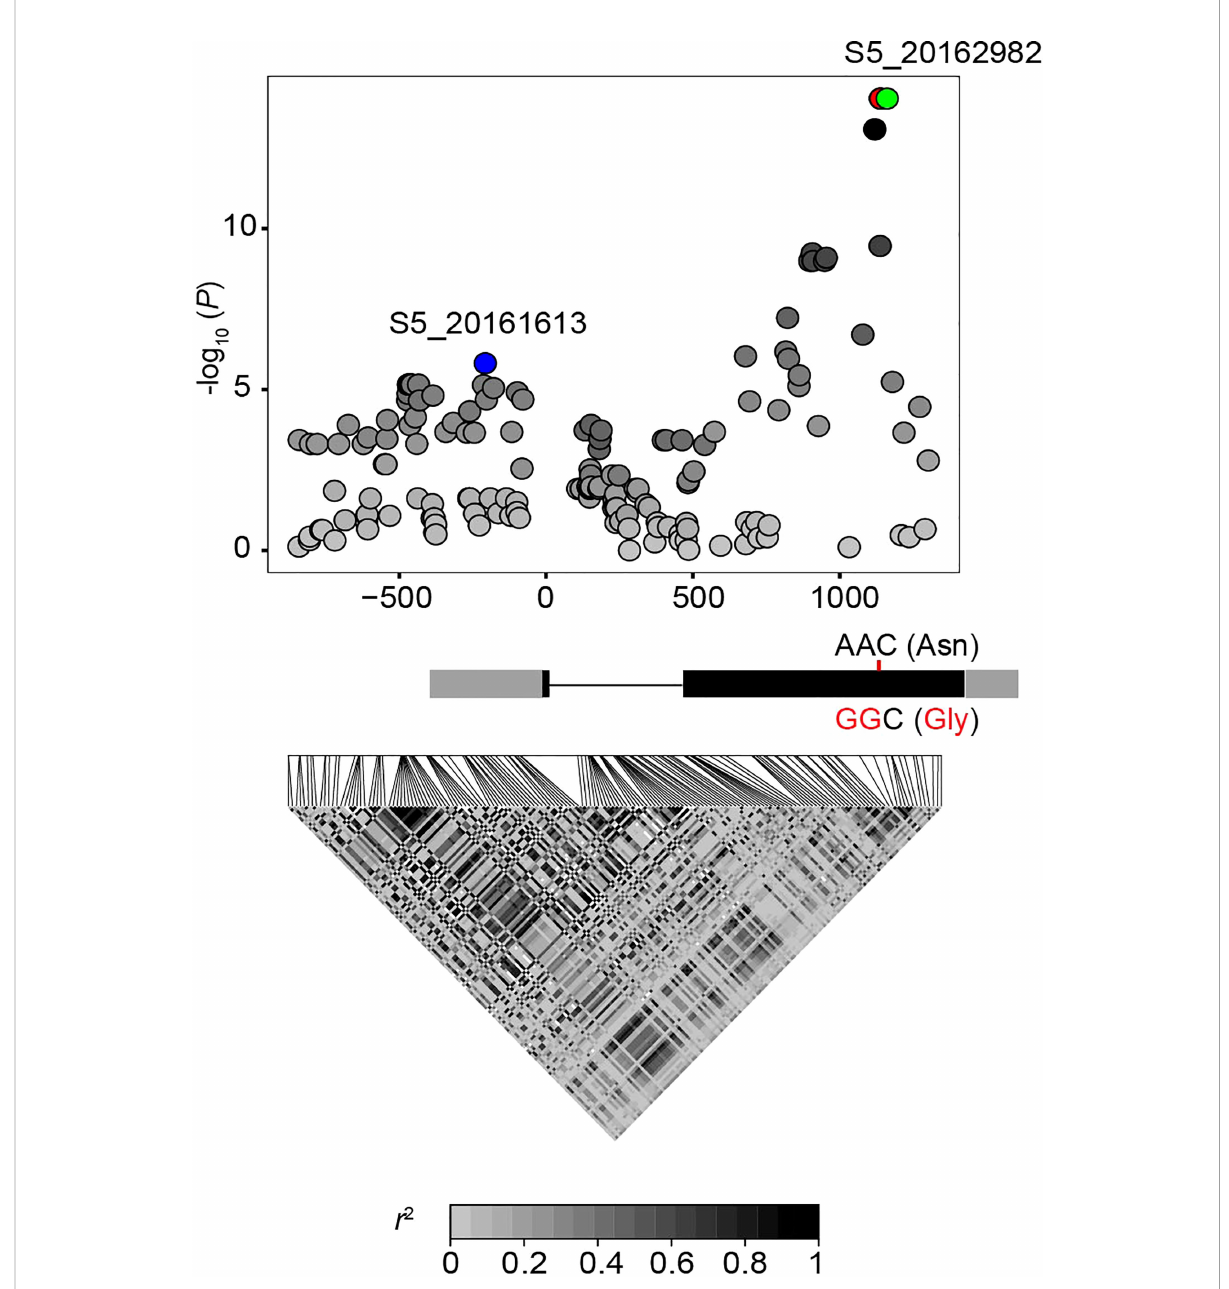
FIGURE 4 ZmFCL -based association mapping and LD analysis of 215 sweet corn inbred lines. The most signi fi cant SNP (S5_20162982) of GWAS for 5- FTHF is indicated in green, while the most signi fi cant SNP of ZmFCL expression is indicated in blue. The two adjacent signi fi cant SNPs were highlighted with red dots. The intensity of gray shading indicates the extent of linkage disequilibrium ( r 2 ) between the leading SNP (S5_20162982) and the other variants identi fi ed in this region. The gene structure is shown below the x axis. Black and grey boxes represent exons and UTRs, respectively. The red nucleotides indicate nonsynonymous SNP substitution in the second exon of ZmFCL